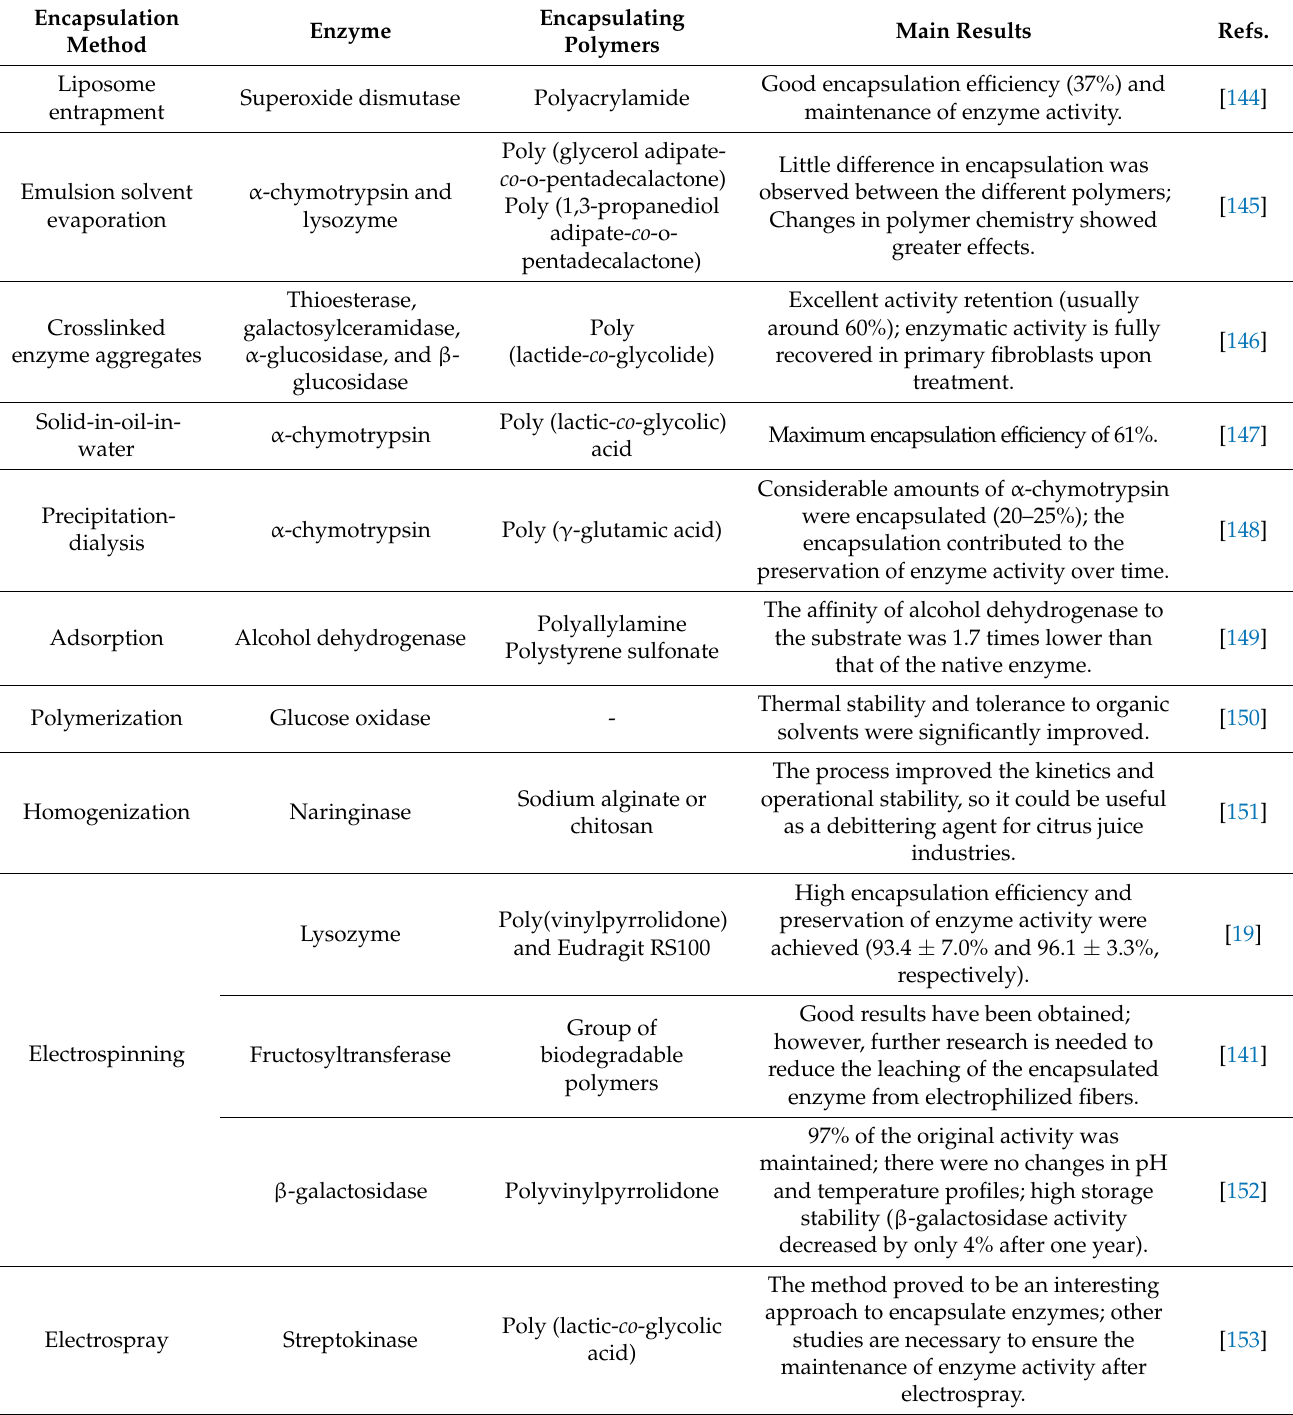
Table 1. Recent research about the encapsulation of enzymes using polymeric